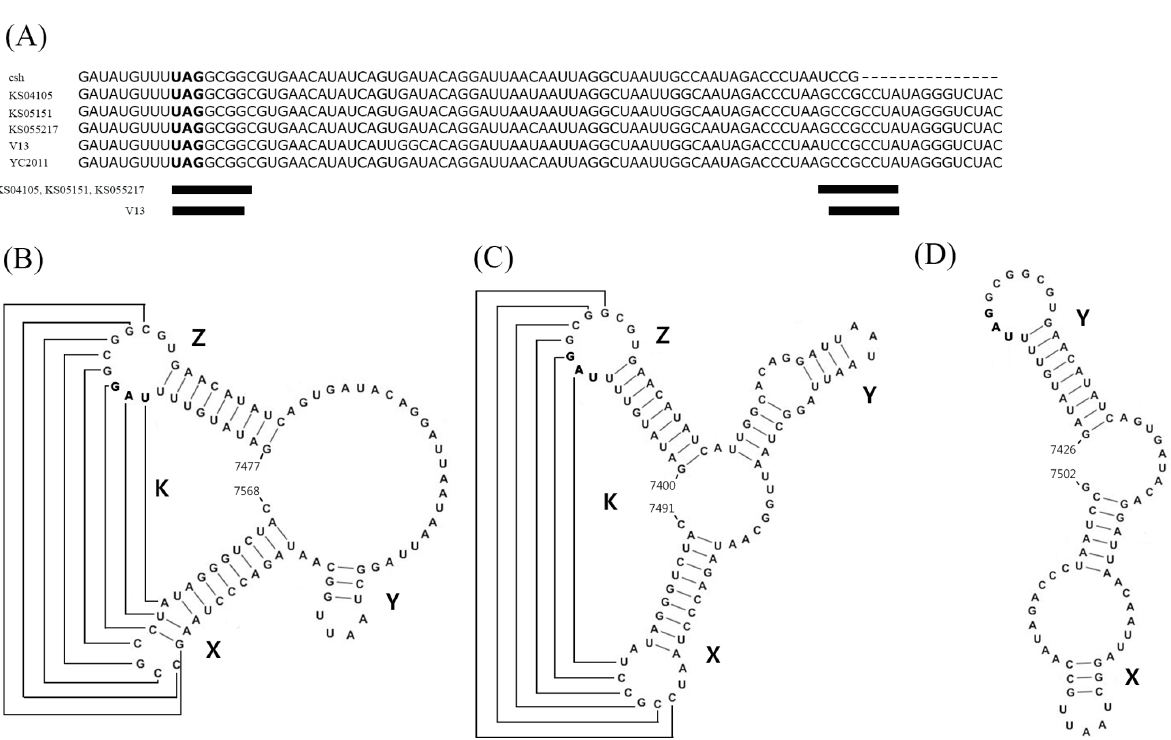
Figure 5. Sequences and structural features of 3 9 untranslated region (UTR) of the porcine sapeloviruses. (A) The nucleotide sequences of the 3 9 UTR were compared using the Clustal W methods. (B–D) Secondary and tertiary structures of 3 9 UTR of strains KS04105, KS05151, KS055217 and YC2011 (B), strain V13 (C), and strain csh (D) were predicted by the CLC program. Proposed tertiary interactions between the loops of X and Z domains are shown by lines.